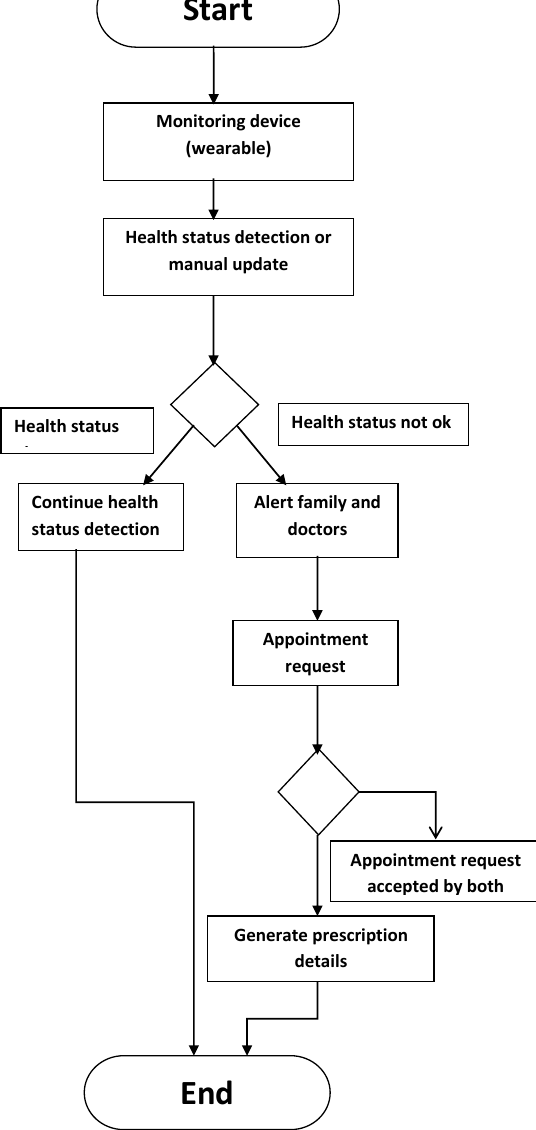
Fig. 2. Working process of